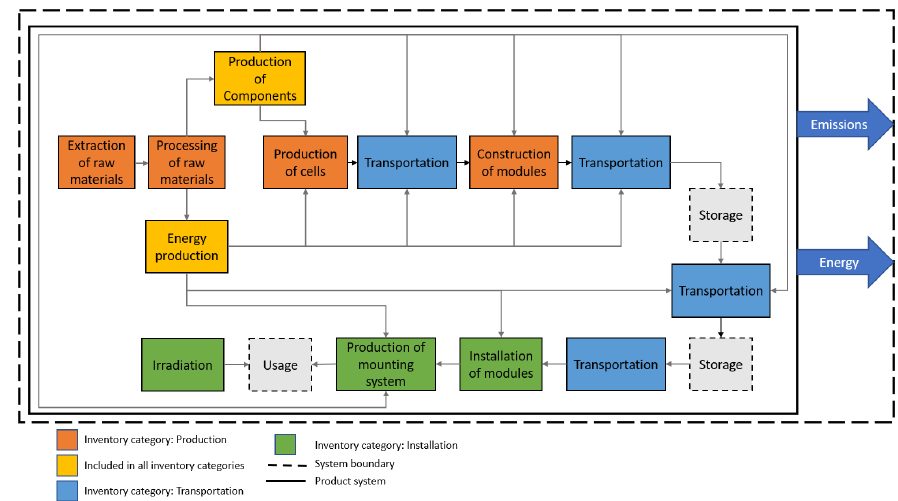
Figure 3. Photovoltaic system boundary.